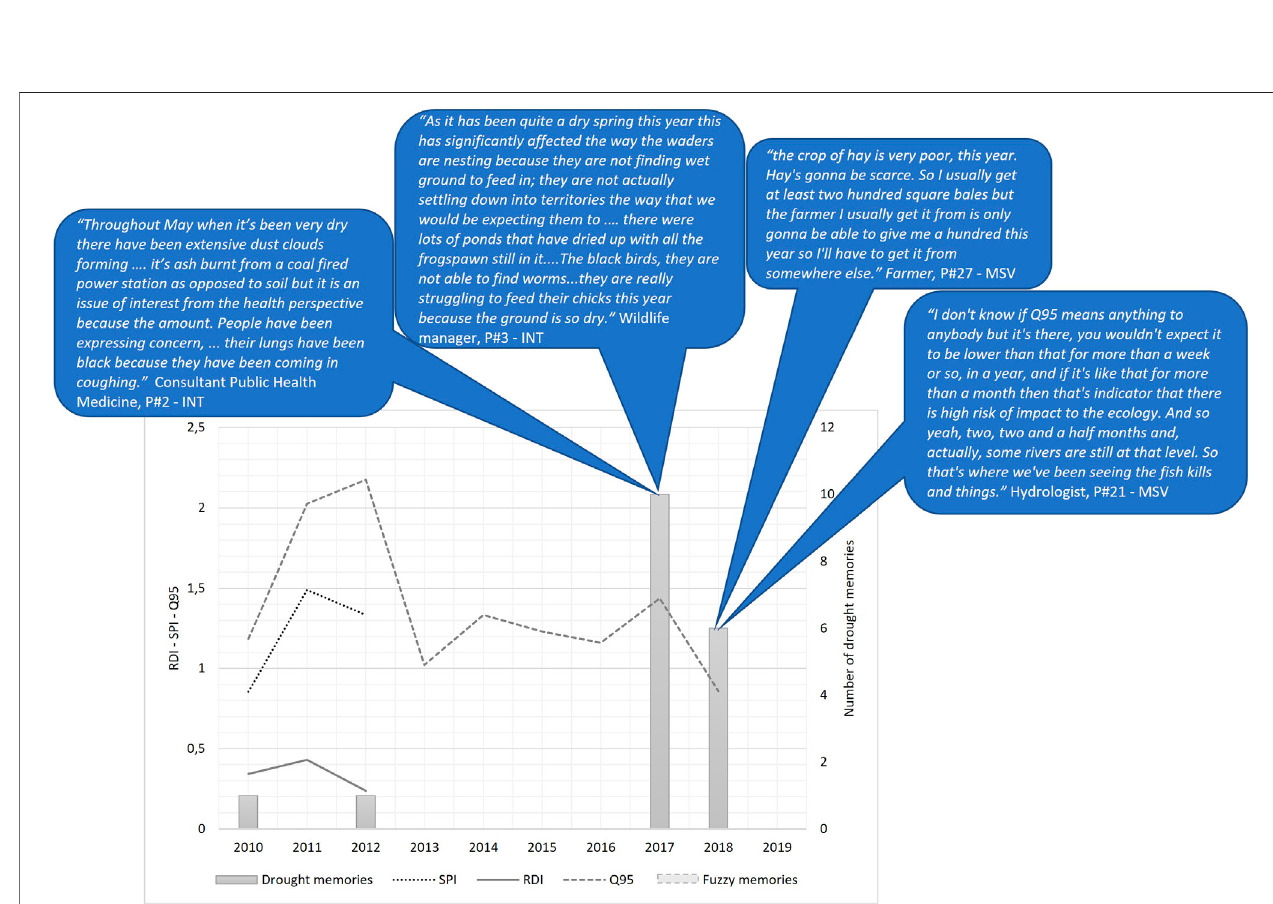
FIGURE 7 | Drought memories overlaid with RDI, SPI and Q 95 data for the decade 2010 to 2019. RDI and SPI data are only available to 2012. Q 95 data are used here to provide an indicator of local river levels for comparison with narratives.